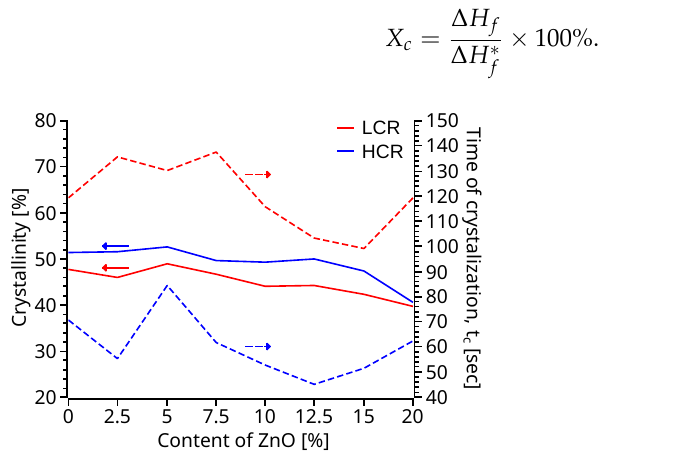
Figure 3. Comparison of the crystallinity percentage and the time of crystallization, t c as function of the ZnO sample content and cooling